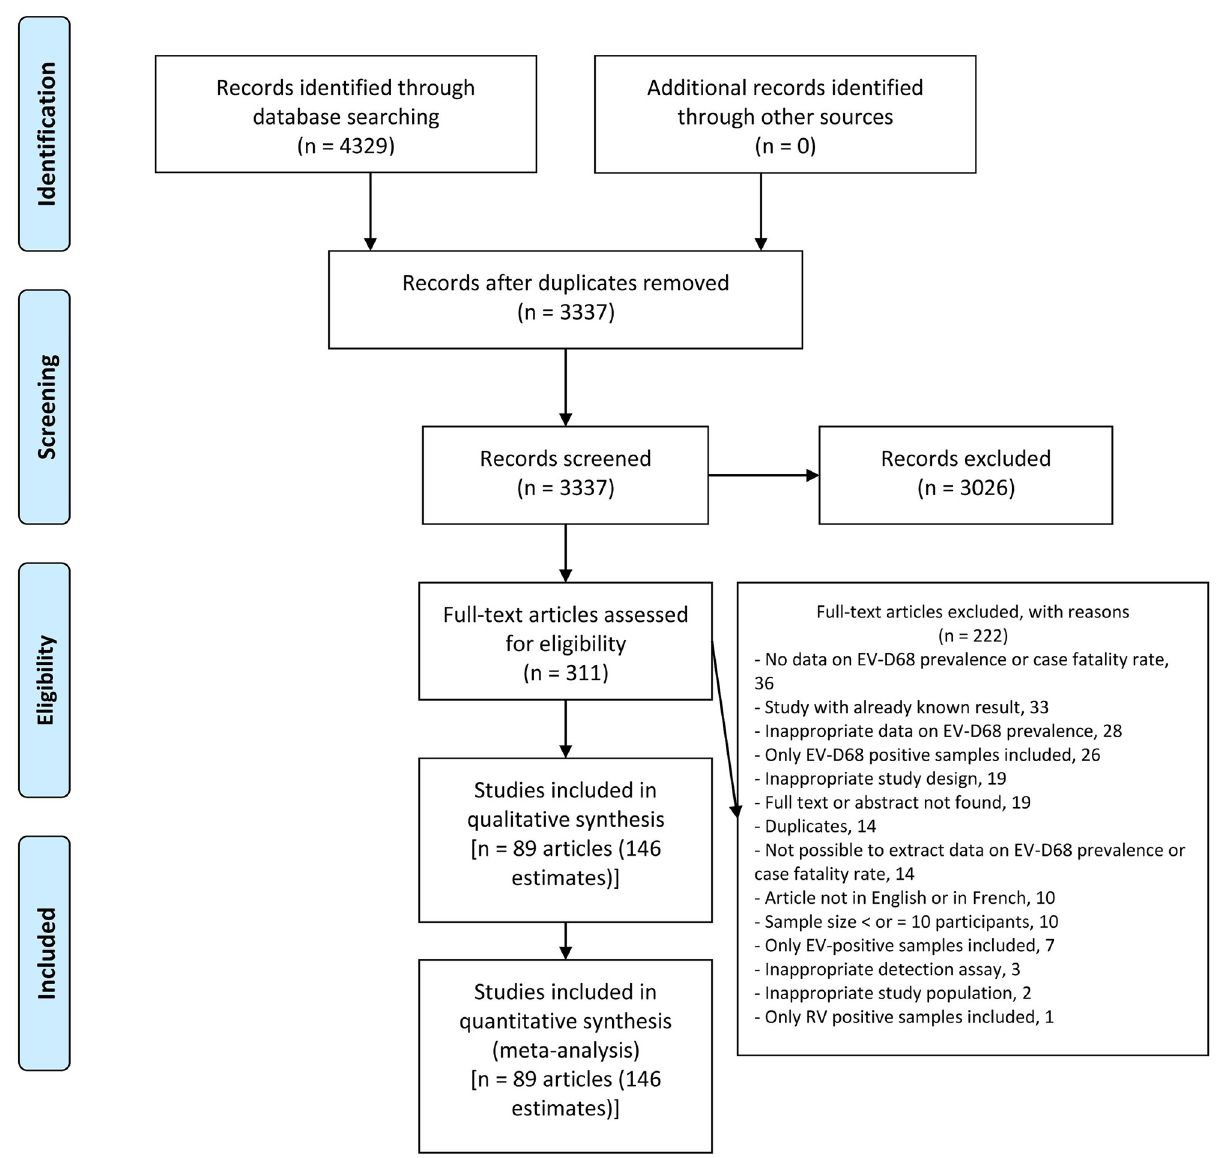
Fig 1. Flow diagram summarizing the selection of eligible